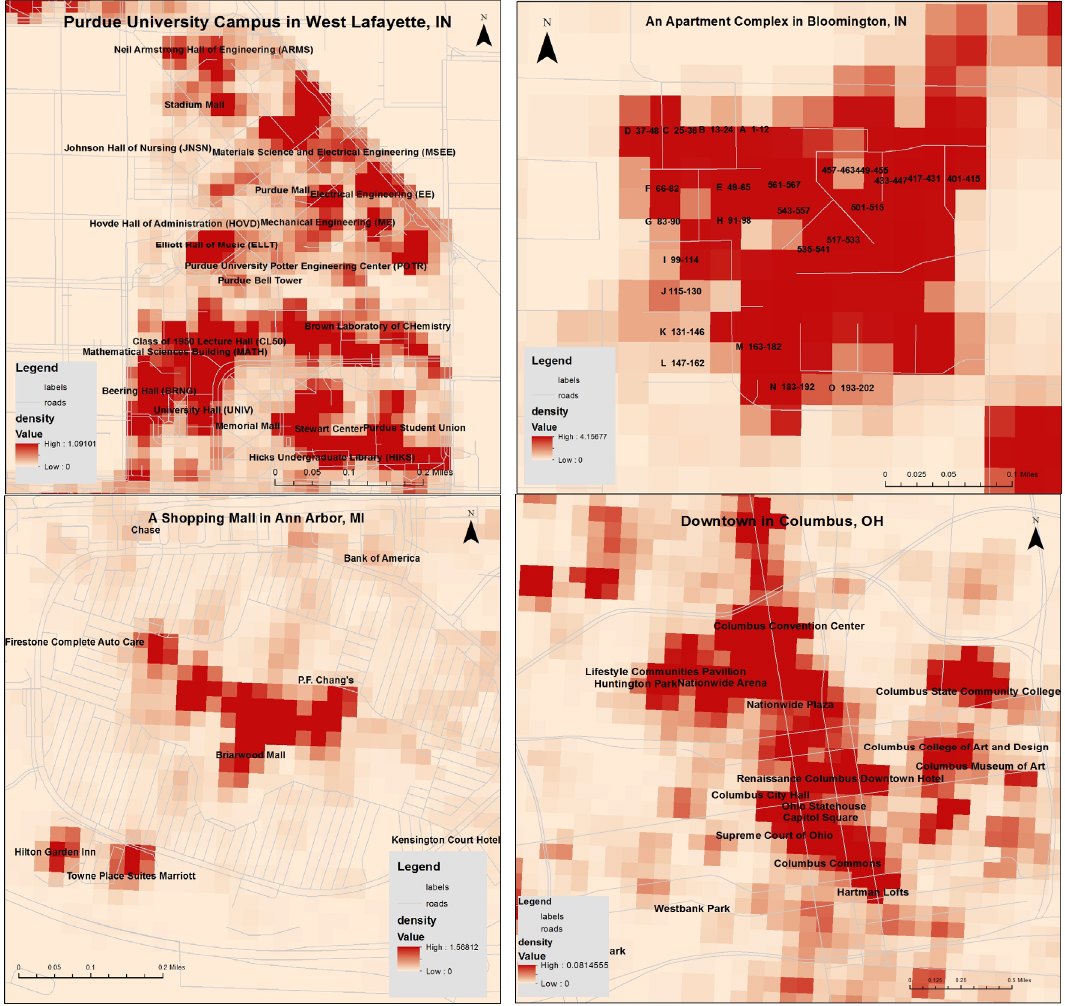
Figure 2. Closer views of selected dense tweet locations in the four cities.